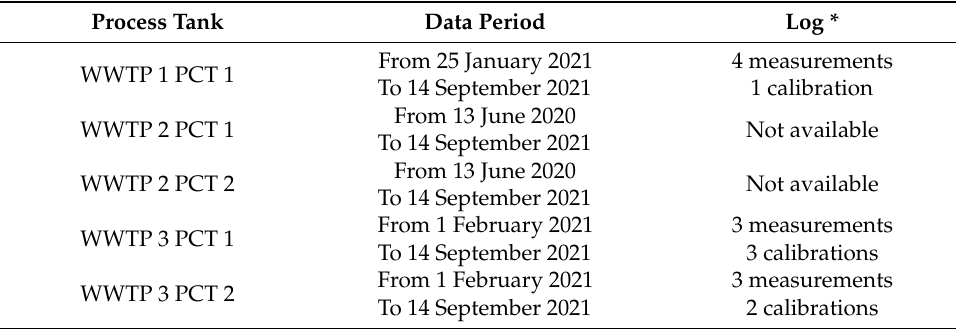
Table 1. Overview of the available